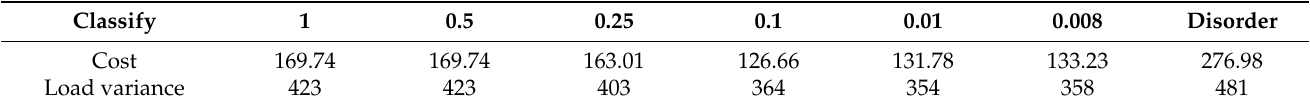
Table 3. Data results with different parameters.